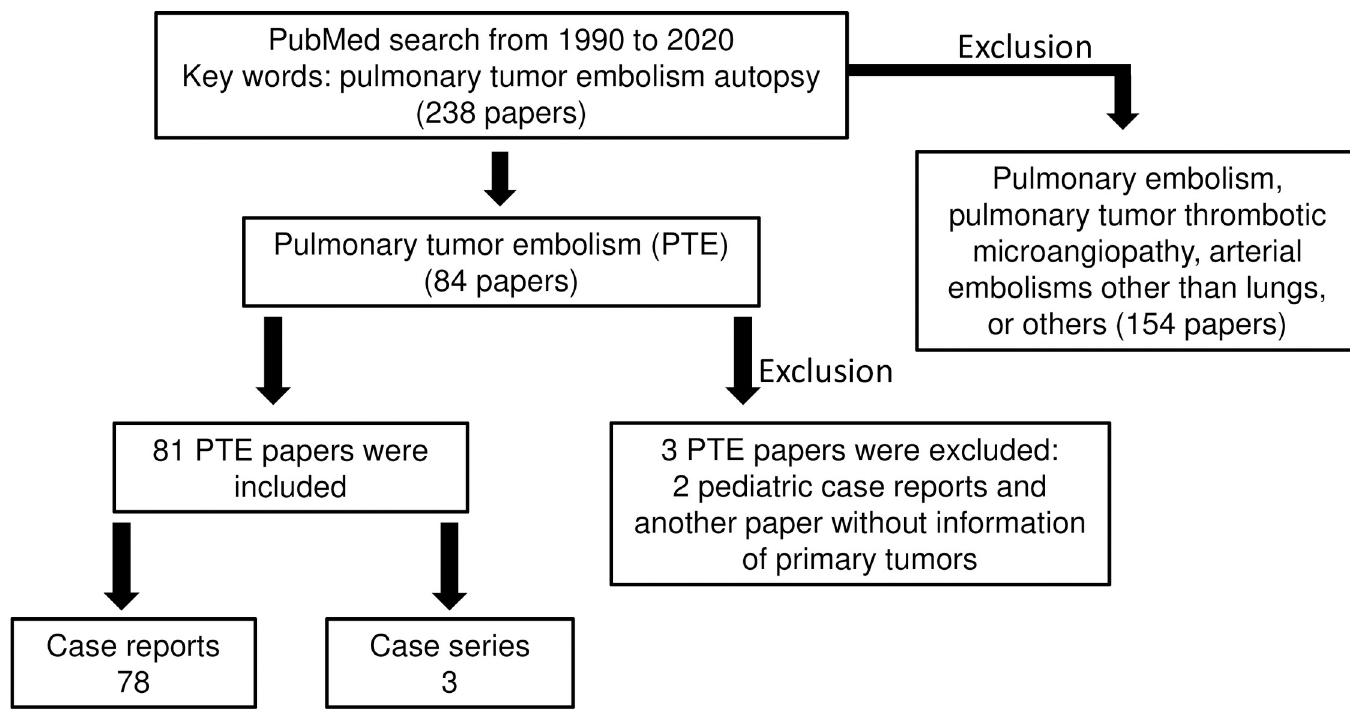
Fig 4. Flowchart of the literature review from 1990 to